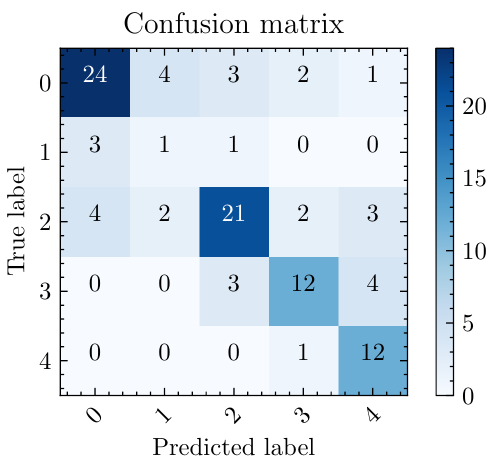
Figure 4. Quantitative results in the form of confusion matrix on IDRID’s DR grading dataset with our proposed framework. Horizontal axis indicates the predicted classes and vertical axis indicates the ground truth